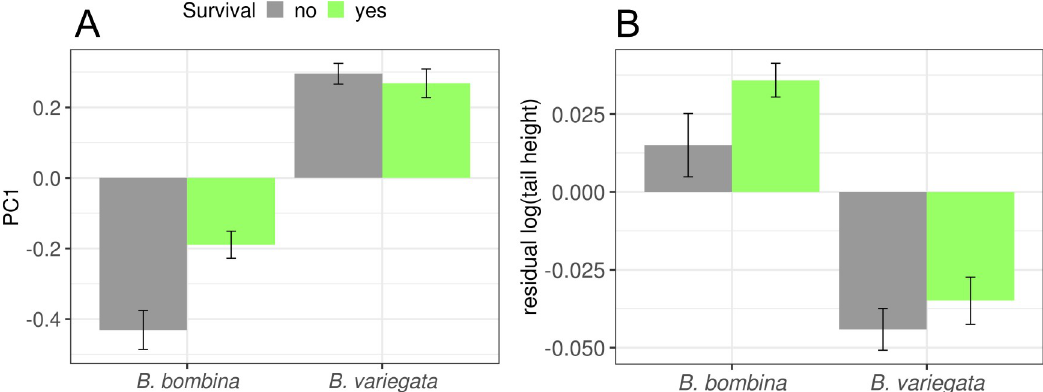
Fig 5. Means of body size and tail shape by taxon and survival. Plotted are the fitted means from the logistic regression analysis for PC1 (A) and residual log(tail height) (B). Error bars indicate one standard error of the mean.